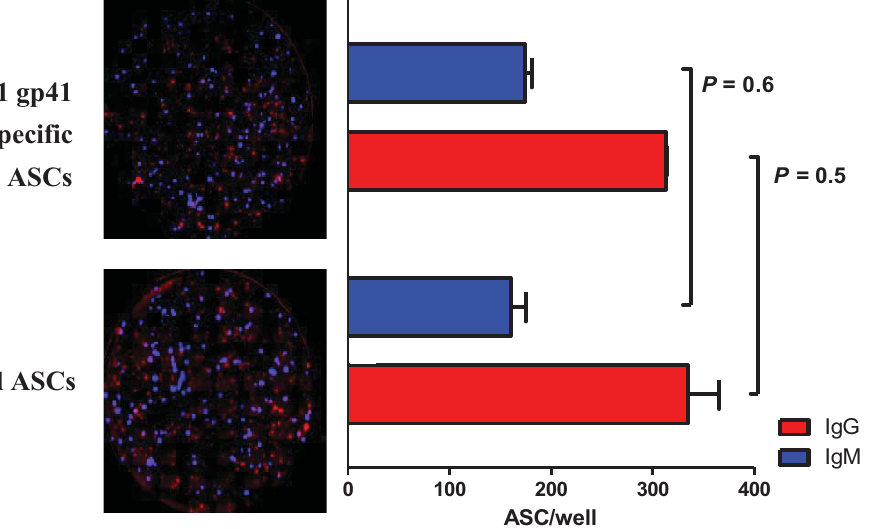
Figure 3. Muliplex detection of total or HIV-1 gp41 Env-specific IgG and IgM antibody-secreting cells. IgG-7B2 and IgM-2B9 cells were co-cultured using either HIV-1 MN gp41 Env (top picture) or a mixture of anti-human IgG and IgM mAbs (bottom